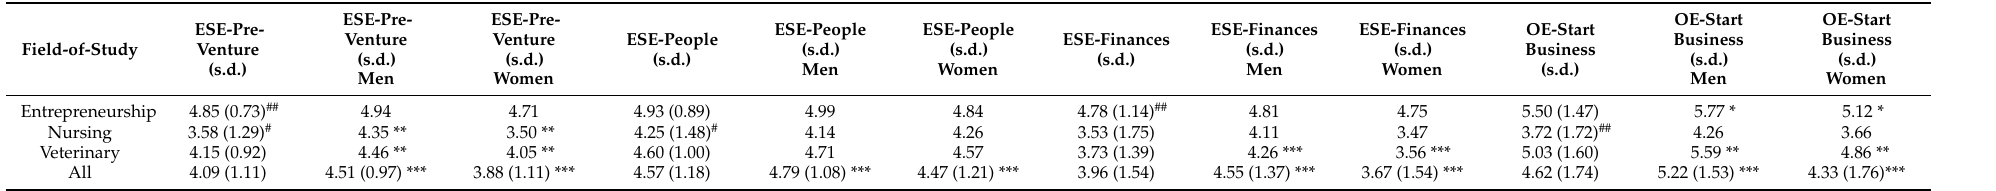
Table 5. Means and standard deviations of entrepreneurial self-efficacies and outcome expectations of business start-up or ownership by field-of-study and gender (n =